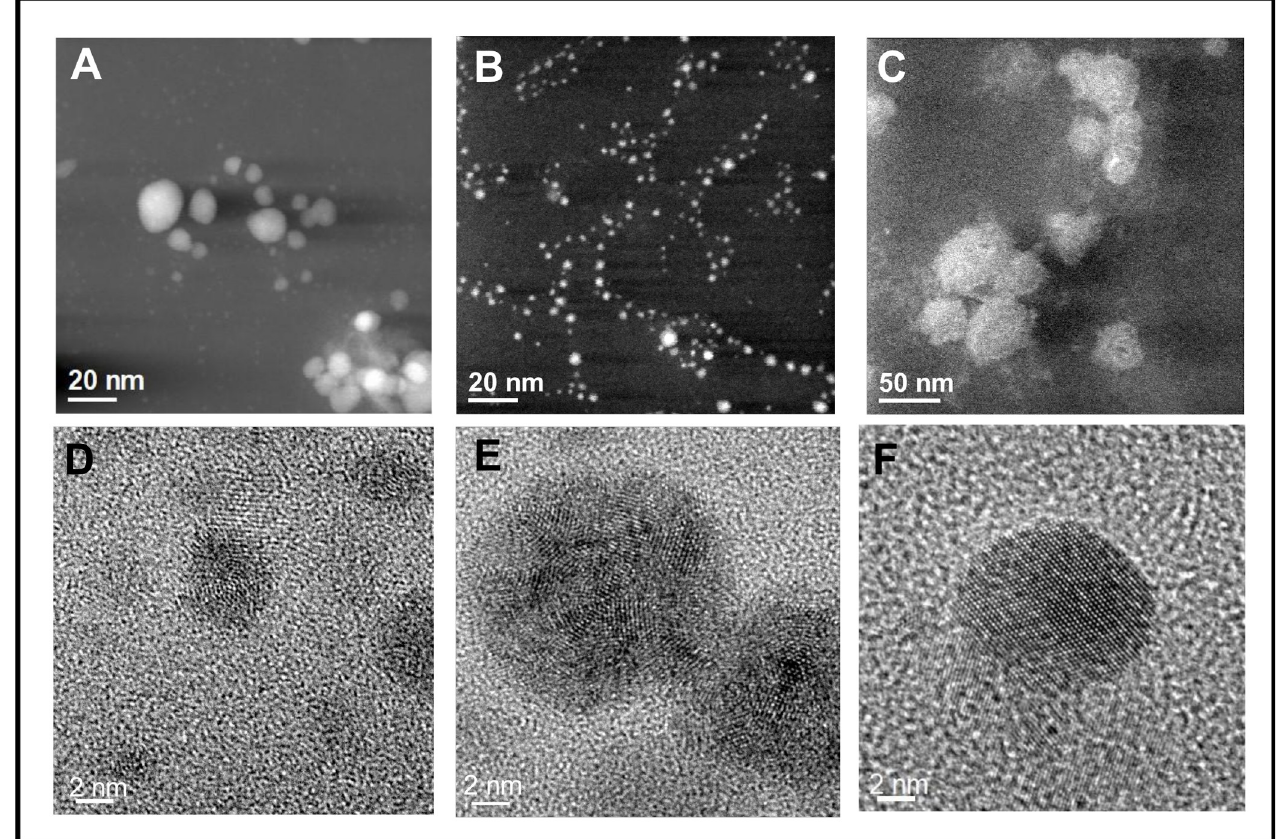
Fig 5. Annular dark field ADF-STEM images (A-C) and HRTEM images (D-F) . The biogenic AgNPs suspension formed by the Ag0.5–5 strain of Fusarium scirpi (A and B) and the fungal water-filtrate without addition of metal used as control (C) were deposited over copper grids. Brighter dots with different sizes of metallic AgNPs (A—B) are displayed in the ADF-STEM images and atomic resolution images of single nanoparticles are showed in lower panels